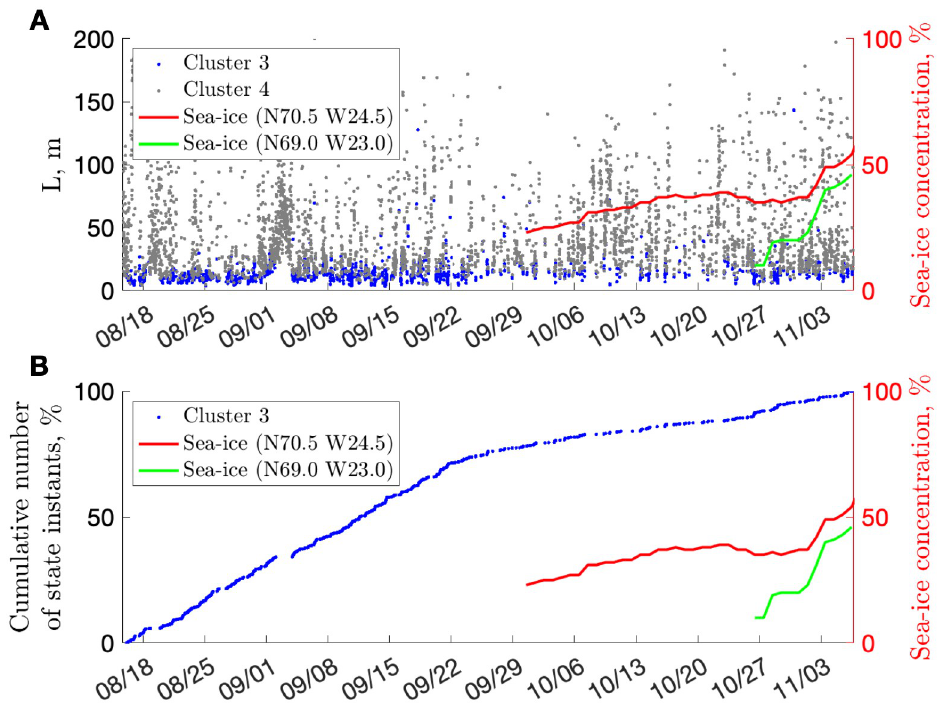
Fig 4. Sea-ice and near-surface behavior. (A) Variation of Euclidian distance for clusters 3 and 4 compared with sea- ice concentration (NOAA). (B) Cumulative number of cluster-3 instants (i.e., binary count such as 1 for “cluster present”, 0 for “cluster not present”). Red indicates sea-ice concentration in the Scoresby Sound fjord (summering ground); green indicates the sea-ice concentration offshore (wintering ground), with typical grounds after [42].